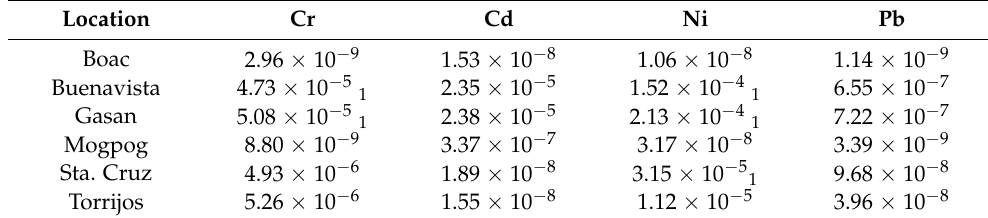
Table 7. The target cancer risk at 75% reduction of vegetable